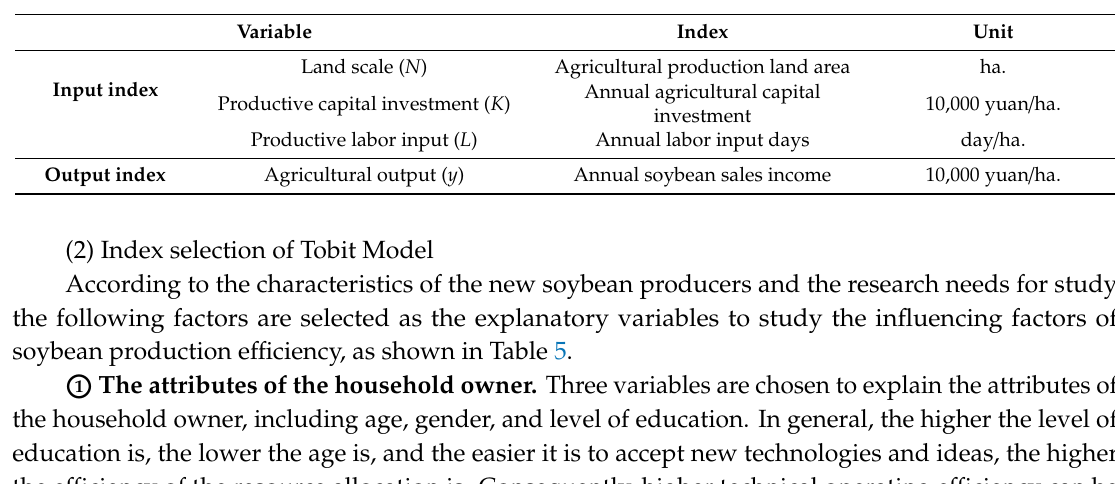
Table 4. Data envelopment analysis (DEA) input–output variables and the corresponding